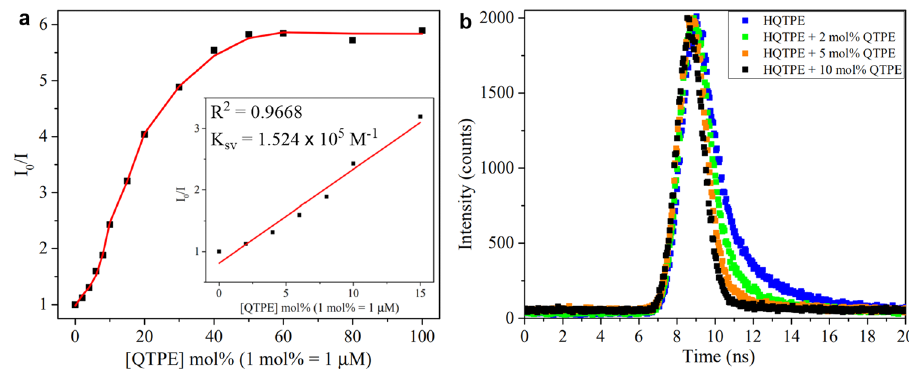
Fig. 5 Quantitative discussion on fl uorescence quenching of HQTPE in the presence of QTPE. a K sv plot for 100 μ M HQTPE in THF-H 2 O (vol 1% : 99%) upon separate addition of QTPE (0 – 100 mol%), at an excitation wavelength of 300 nm. Inset: a piecewise linear fi tting curve at the initial stage (from 0 to 15 mol% QTPE). b Fluorescence lifetime decay plots of HQTPE in the absence and presence of QTPE. Table 1 Quantum yield and lifetime parameters of HQTPE in THF-H 2 O (vol 1% : 99%) in the absence and presence of QTPE.